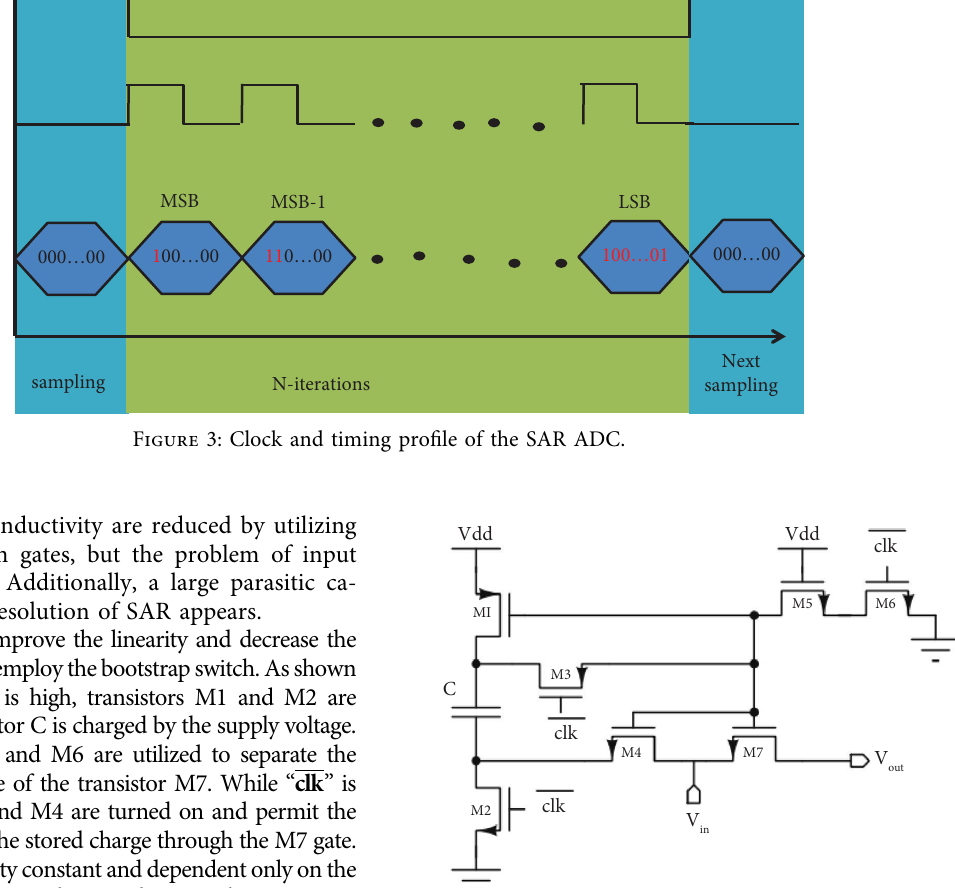
Figure 4: Te conventional bootstrapped sample and hold circuit [63].